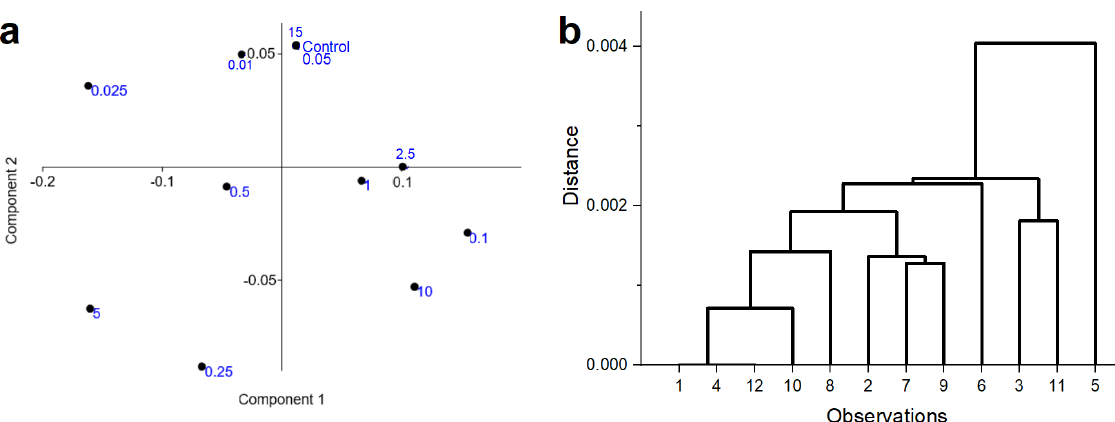
Figure 6. PCA ( a ) and HCA ( b ) analysis of: control (1) and treated with different concentrations of algae: 0.01 (2); 0.025 (3); 0.05 (4); 0.1 (5); 0.25 (6); 0.5 (7); 1 (8); 2.5 (9); 5 (10); 10 (11); 15 (12). Two-dimensional (2D) scores plot of samples with differences in chemical compositions, as presented through all the spectral regions.